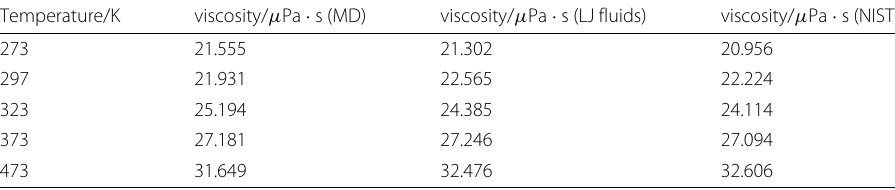
Table 1 Gas viscosities at 1 atm pressure, calculated from MD using the equilibrium Green-Kubo approach